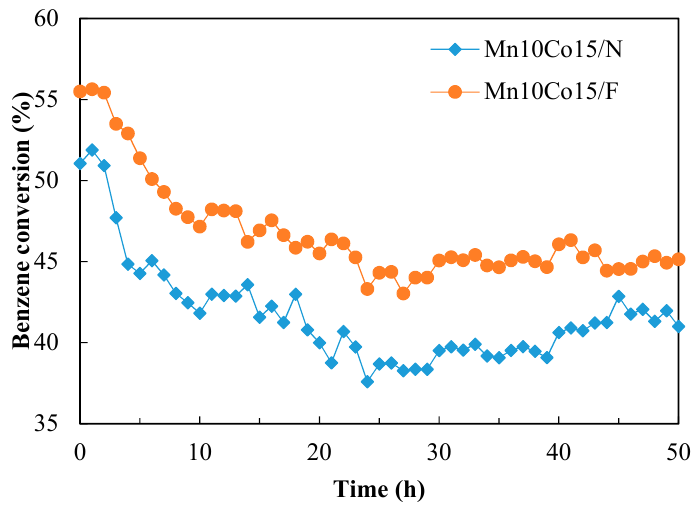
Figure 7. Average yields of CO 2 achieved over three runs on ( a ) Mn x Co y /N, ( b ) Mn x Co y /F during the light-off experiments.